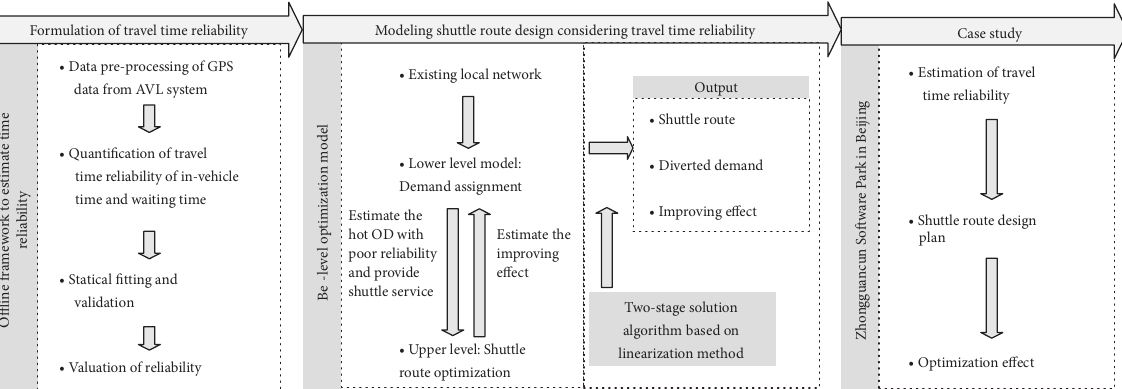
Figure 1: Flowchart of the method Table 1: Sample of GPS data.